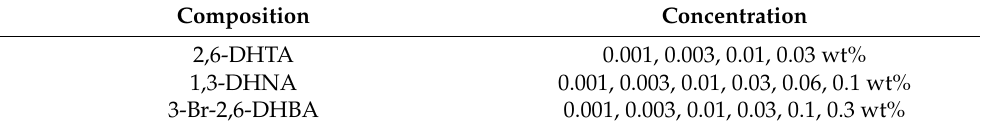
Table 1. Compositions of and types of modification solutions used in Step 2.